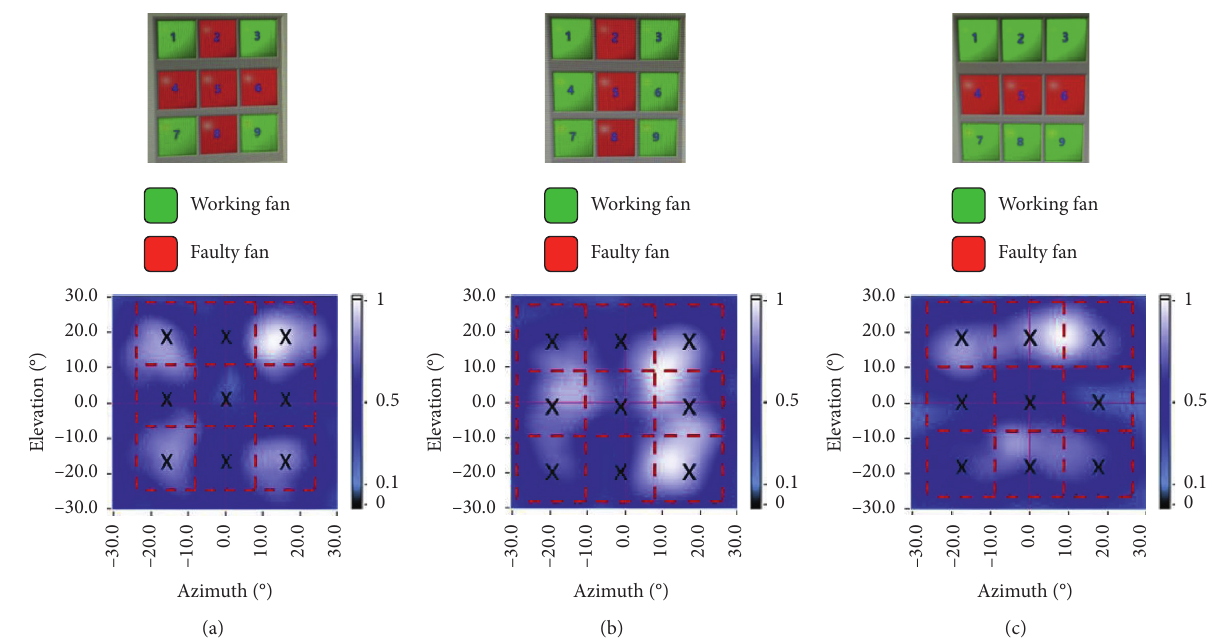
Figure 5: Acoustic images of faulty fan matrices: (a) only the fans on the corners are working, (b) the fans of the middle column are faulty, and (c) the fans on the middle row are faulty.